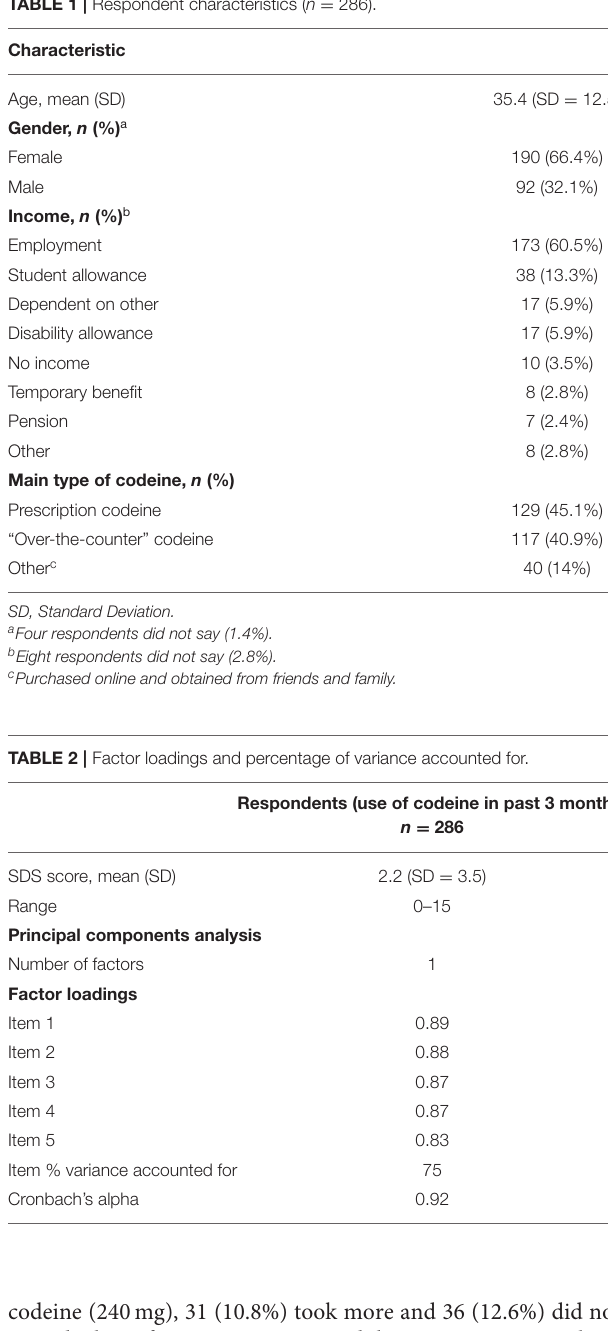
TABLE 1 | Respondent characteristics ( n = 286).